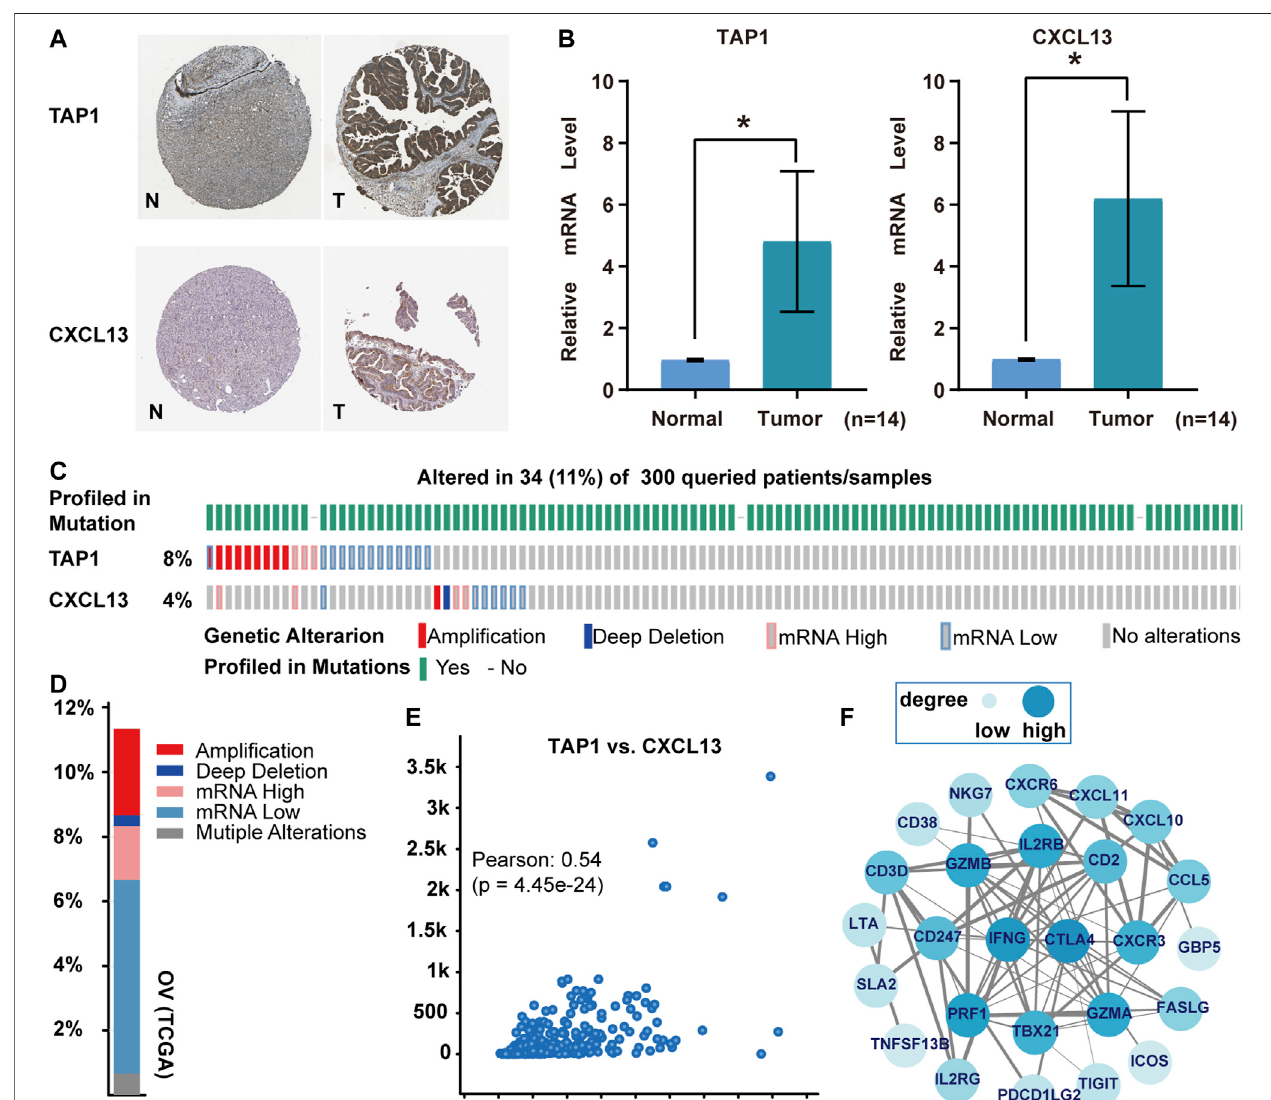
FIGURE 9 | Protein expression and mutation analysis of TAP1 and CXCL13 in ovarian cancer. (A) Protein expression on the Human Protein Atlas. “ N ” was normal tissue, “ T ” was tumor tissue. (B) TAP1 mRNA and CXCL13 mRNA by qRT-PCR in ovarian cancer tissues and surrounding normal tissues ( n (cid:1) 14). * p < 0.05. (C, D) Genetic alterations on the cBioPortal. (E) Correlation between TAP1 and CXCL13. (F) Network of most frequently altered neighbor genes (combined score > 0.7). The thickness of the connecting line indicated the level of combined-score, the higher the score, the thicker the line.